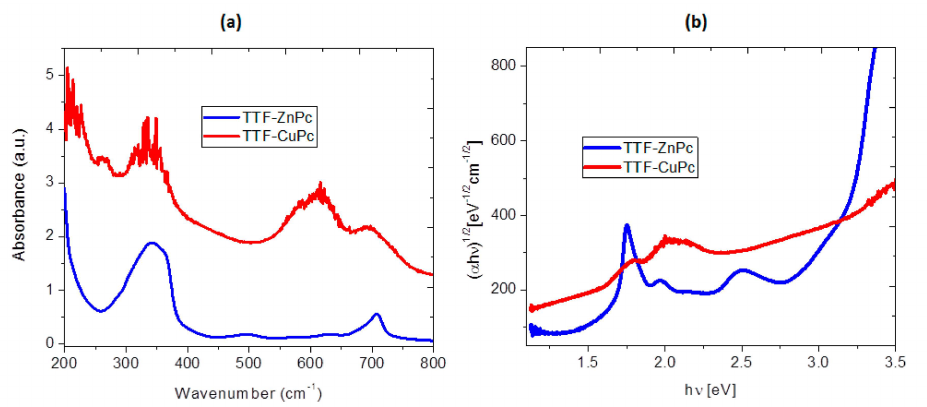
Figure 4. ( a ) Absorption spectra of the MPc and TTF deriv -MPc thin films and ( b ) plot of ( α h ν ) 1/2 vs. photon energy h ν of the TTF deriv -MPc films.